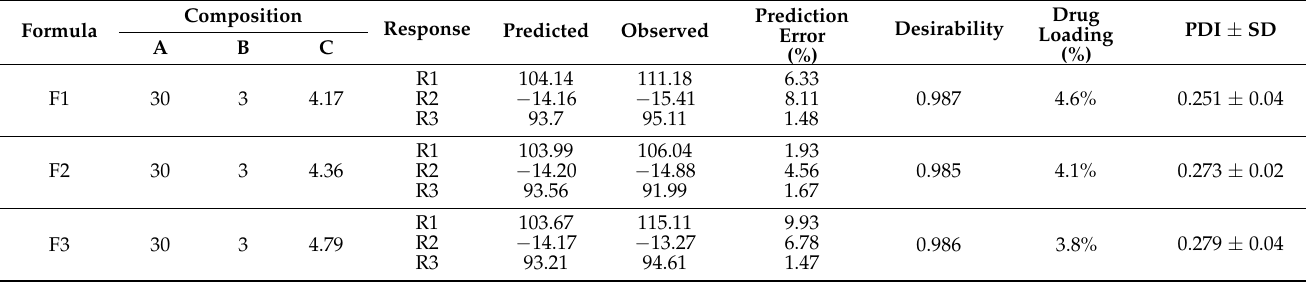
Table 5. Composition of the selected optimized NIC–NLC formulations with different predicted and observed response values with prediction